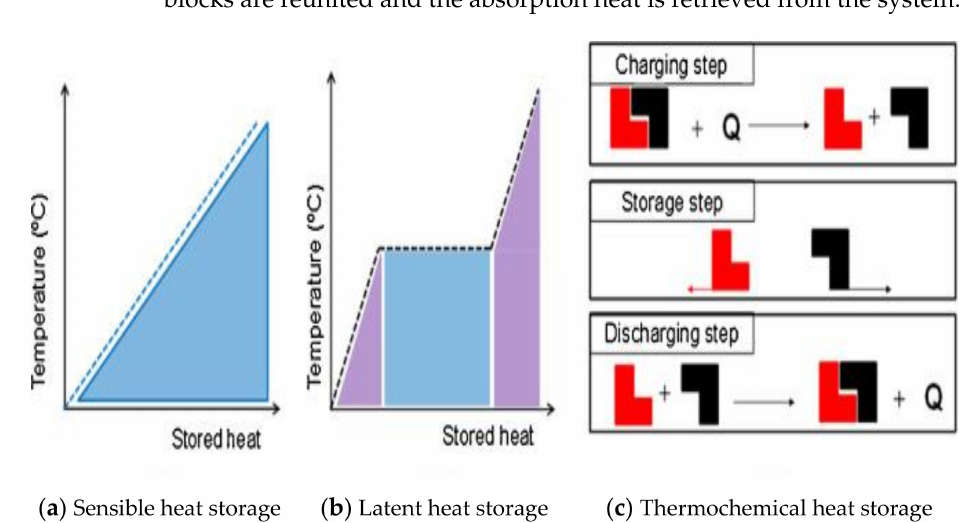
Figure 1. Different approaches for TES [15]: ( a ) Sensible heat storage; ( b ) Latent heat storage; ( c ) Thermochemical heat storage. The red and black blocks represent molecular blocks with Q as absorption heat.